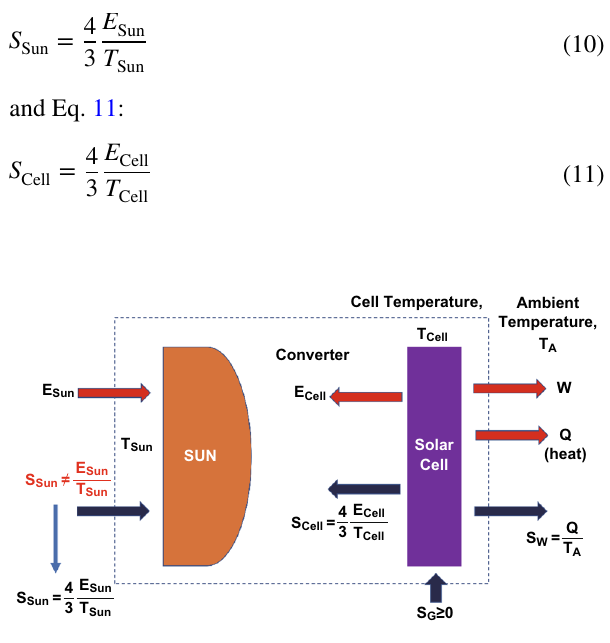
Fig. 3 Schematic diagram of the Landsberg model for a solar con-